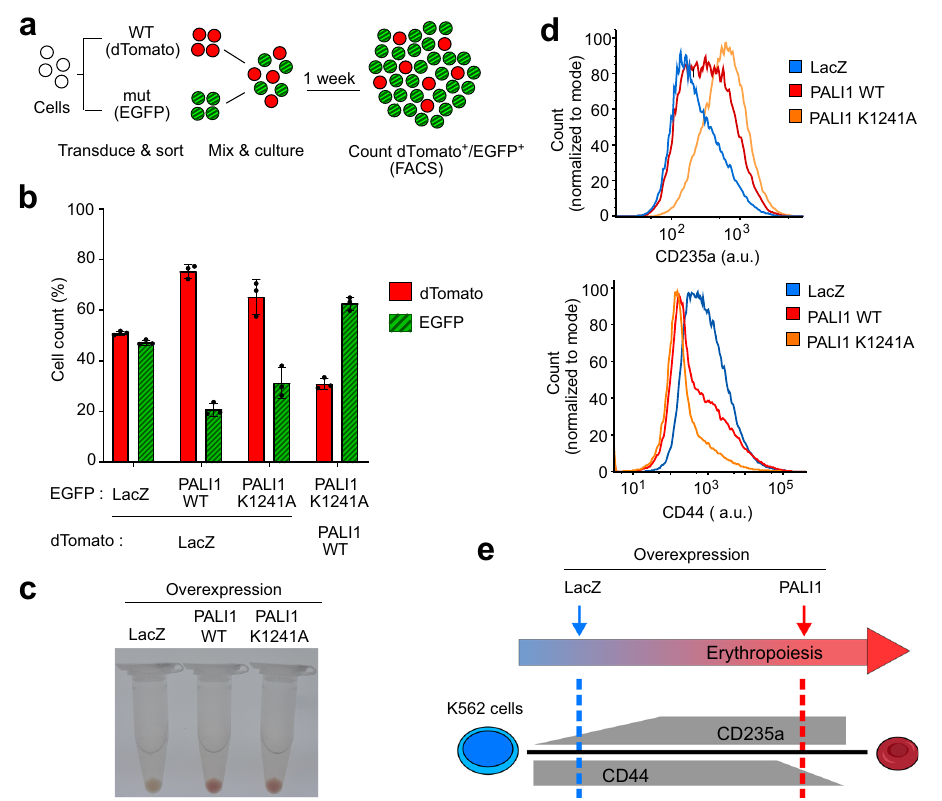
Fig. 8 Overexpression of PALI1 triggers K562 cell differentiation along the erythroid lineage, with the effect altered by a separation-of-function allosteric-defective PALI1 mutant (K1241A). a Schematic illustration of the competitive cell proliferation assay used to directly compare the proliferation of cells transduced with different constructs. Cells overexpressing different proteins and fl uorophores are co-cultured, with the higher-proliferating cells outcompete the lower-proliferating cells. At the end of the experiment, the number of cells carries each vector is quanti fi ed using fl ow cytometry. b Competitive cell proliferation assay of human chronic myeloid leukaemia (K562) cells overexpressing either PALI1 wild-type (WT), the separation-of- function PALI1 mutant (K1241A) or the LacZ negative control, as indicated. The bar plot represents the mean percentage of each cell population after 7 days of competition, as quanti fi ed using fl ow cytometry. Error bars represent standard deviations derived from three independent experiments carried out on different days with the observed values indicated by dots. Evidence for protein expression and nuclear localisation are in Supplementary Fig. 5a. Source data are provided as a Source Data fi le. c Colour photographs of pelleted K562 cells overexpressing different proteins: LacZ (left), PALI1 WT (middle) and PALI1-K1241A mutant (right). d Representative histograms generated from fl ow cytometric analysis of the differentiation markers CD235a (top) and CD44 (bottom) exhibited by K562 cells overexpressing PALI1 WT (red), PALI1 K1241A mutant (orange) or LacZ (blue). The other two replicates shown in Supplementary Fig. 9a, b and evidence for protein expression are in Supplementary Fig 8a. e Illustration of the expected expression level of CD235a and CD44 during erythropoiesis (grey) and the actual observed values represented in dashed lines coloured in red and blue for PALI1 and the negative control LacZ,